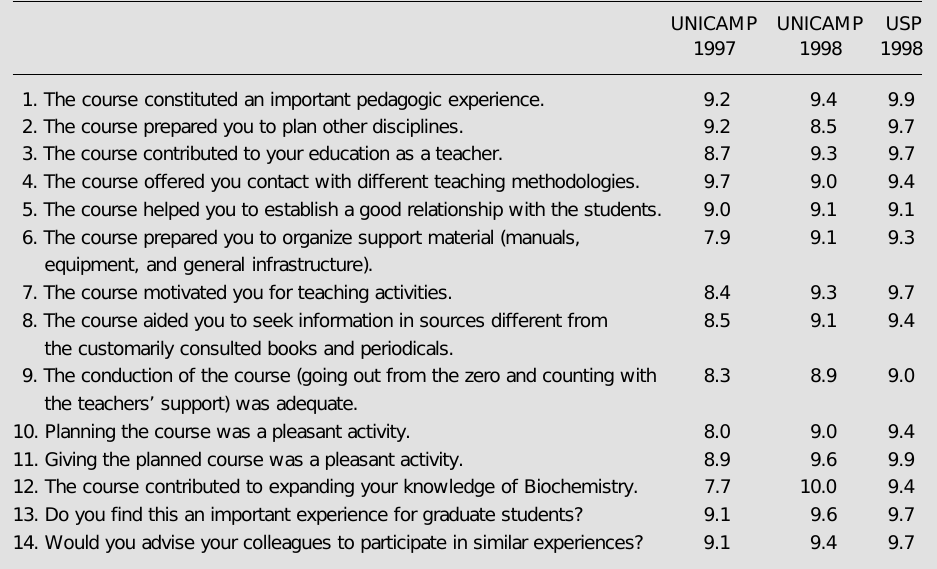
Table 2 - Evaluation of the “Biochemistry Teaching” course by the graduate students. The numbers presented here are the average answers on a scale from 1 to 10. The questionnaire was answered by 91% (UNICAMP, 1997), 80% (UNICAMP, 1998) and 100% (USP, 1998) of the